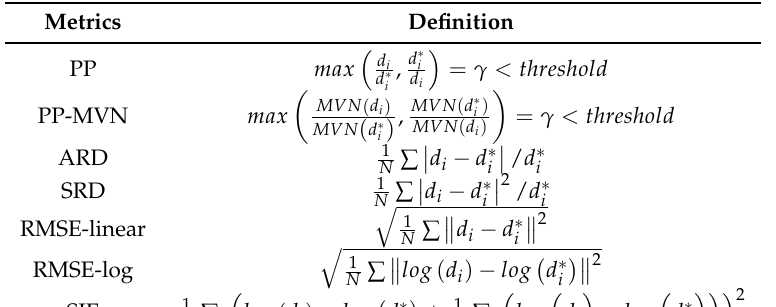
Table 3. Definition of the evaluation metrics: for depth estimation: Percentage of Pixel (PP), PP-MVN Absolute Relative Difference (ARD), Square Relative Difference (SRD), RMSE-linear, RMSE-log and Scale-Invariant Error (SIE).